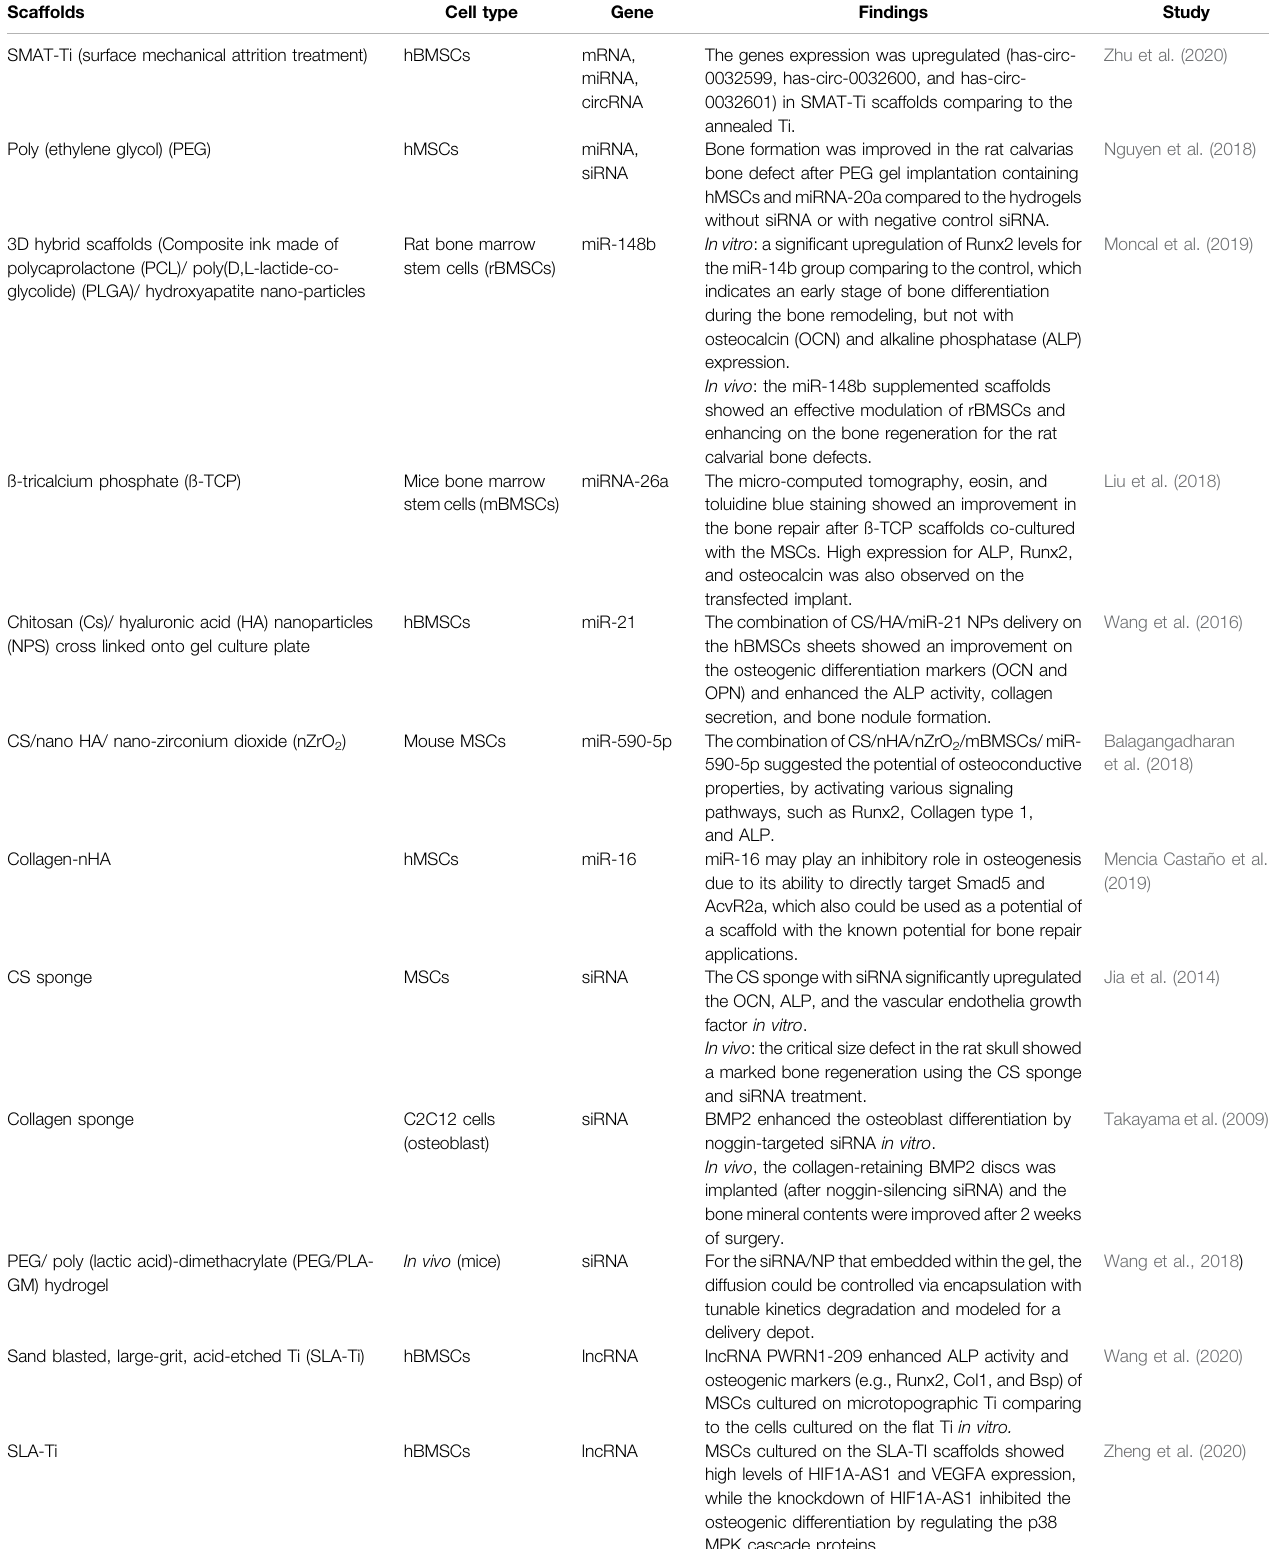
TABLE 5 | RNA-based scaffolds used for bone